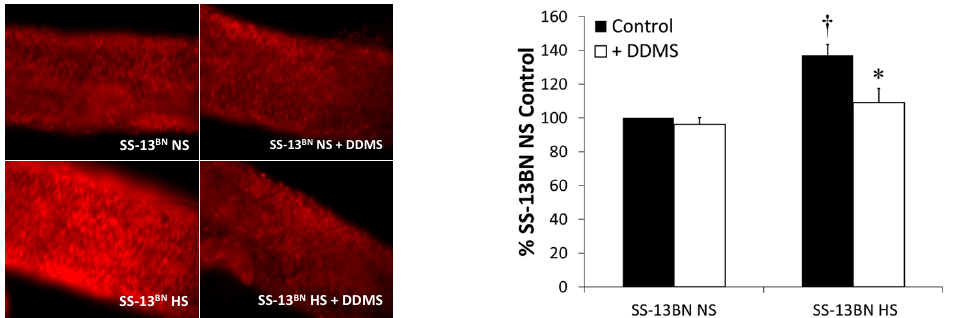
Figure 4. Vascular reactive oxygen species evaluated by DHE fl uorescence in basilar arteries of normal-salt (NS)- and high-salt (HS)-fed SS-13 BN consomic rats in either control conditions or incubated with DDMS (n = 4–5 for all groups). Data are presented as % of DHE fl uorescence (raw fl uorescence units) in basilar arteries from NS-fed SS-13 BN rats. * p < 0.05, signi fi cantly di ff erent from HS-fed SS-13 BN ; † p < 0.05, signi fi cantly di ff erent from NS-fed SS-13 BN ± DDMS.